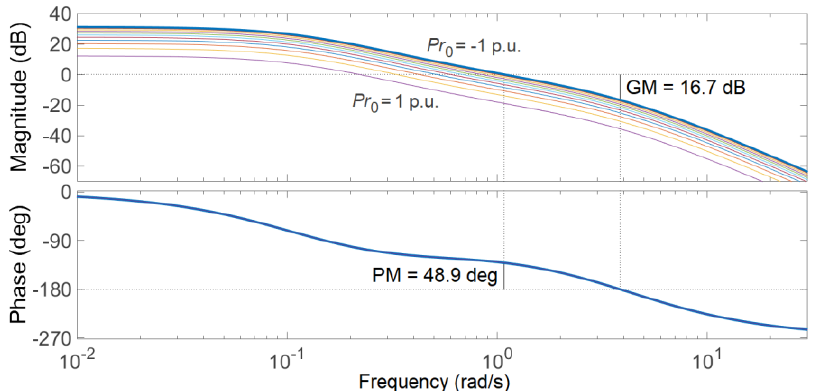
Figure 5. Bode plot of the loop gain transfer functions of the linearized system in the price range of [–1, 1] p.u., indicating ample stability margins in the worst-case scenario.